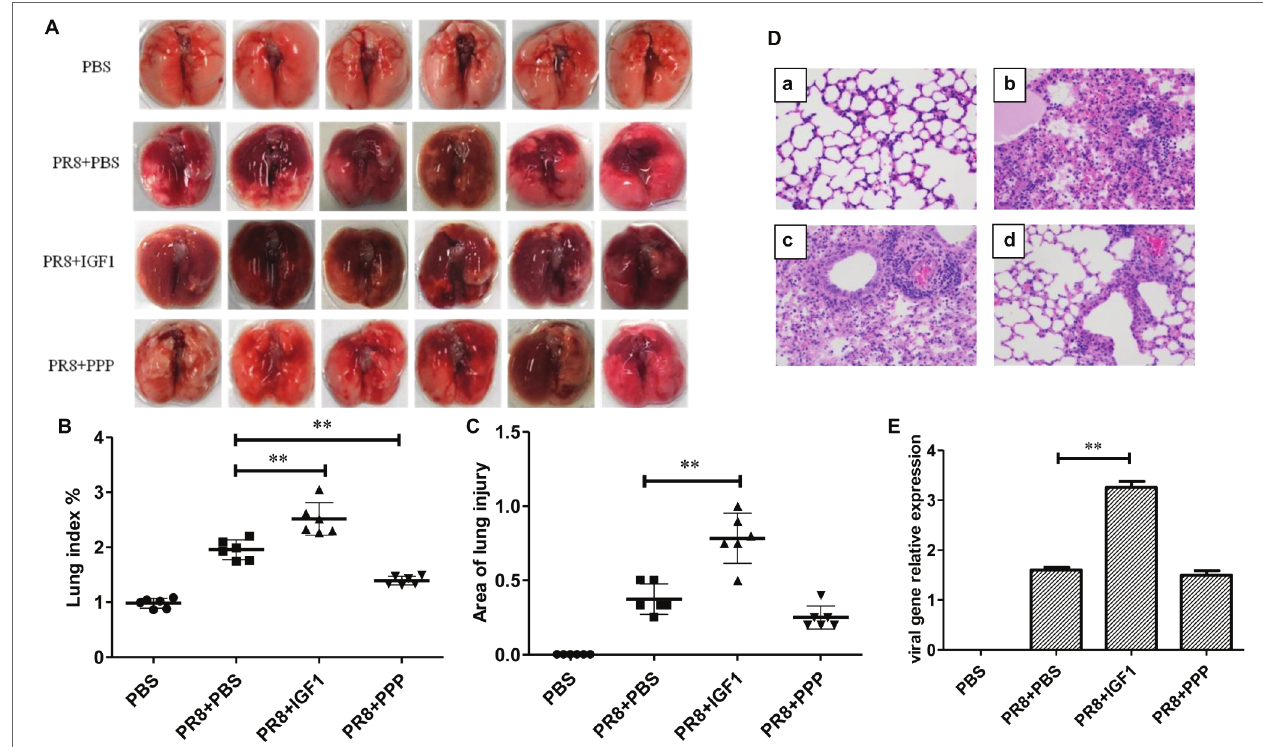
FIGURE 5 | Lung injury following PR8 infection in BALB/c mice. Groups of BALB/c mice ( n = 6, females, 6–8 weeks) were intranasally infected with PR8 (50LD 50 ), treated with IGF1 or PPP, and at day 5 post-infection, the mice lungs were examined for changes in (A) morphology, (B) lung injury, (C) injury areas, (D) histopathology, and (E) viral load. Data were the means ± SD from three independent experiments. ** p < 0.01 vs. PR8 + PBS group by t